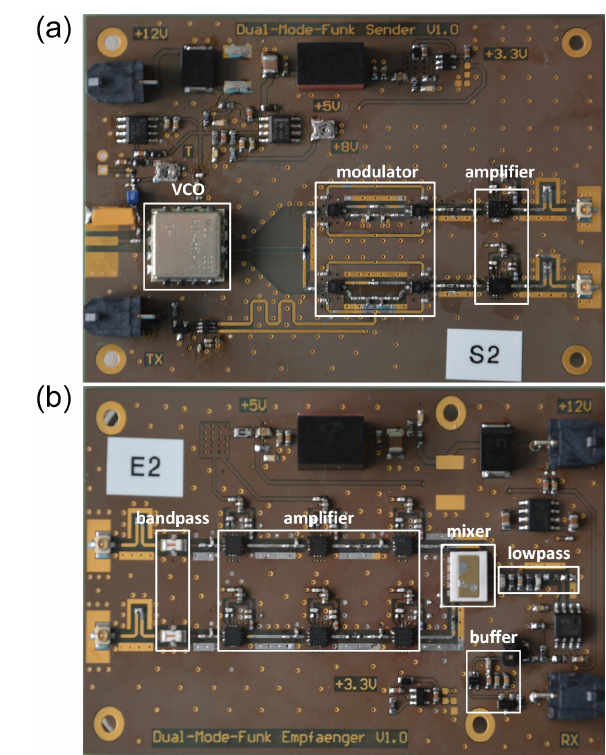
Figure 3. PCB of the transmitter (a) and receiver (b) .